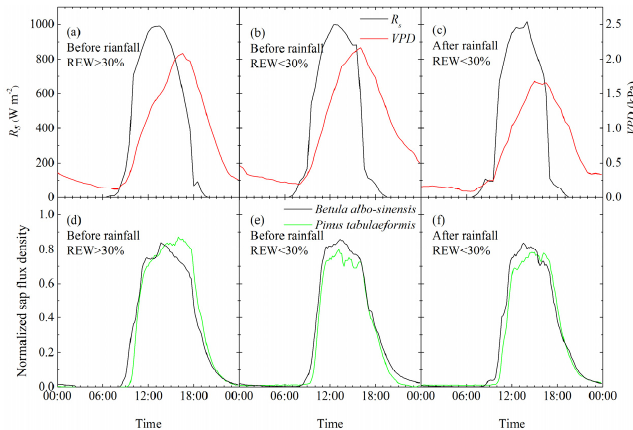
Figure 3. Diurnal courses of the R s (black line in ( a – c )), the VPD (red lines in ( a – c )), and the normalized sap flux density for each tree species on three typical days—i.e., two pre-rainfall days with different soil-water contents, 15 August and 23 August, and a post-rainfall day on 31 August. On 28 August, a heavy rainfall event occurred (22.8 mm). Note that figures on the left, middle and right column represent diurnal courses on 15 August, 23 August and 31 August, respectively. R s , solar radiation; VPD , vapor pressure deficit; REW, relative extractable